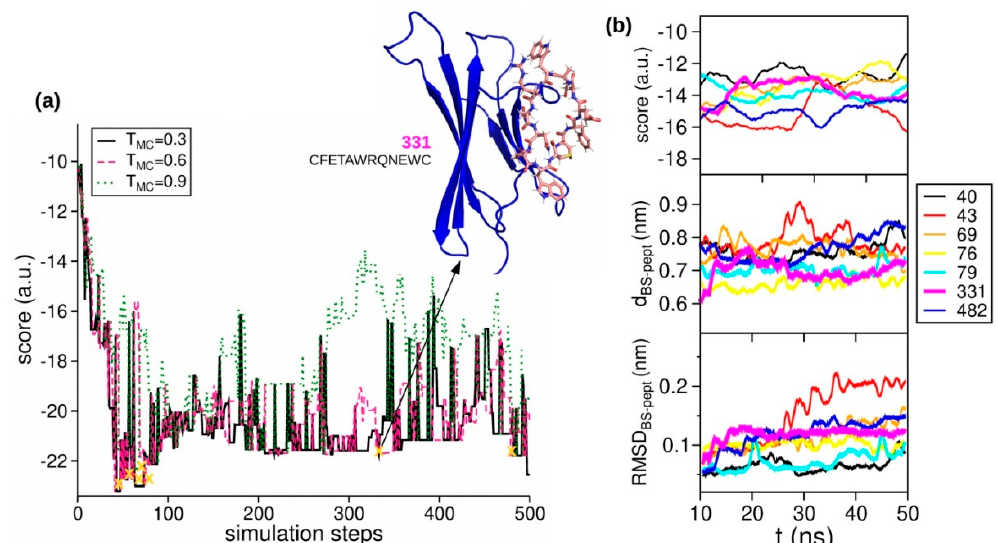
Figure 3. Computational peptide design. ( a ) PARCE optimization path: the optimization was performed by employing three paths with acceptance threshold T MC = 0.3 (black), 0.6 (magenta) 0.9 (green). Peptide mutants that underwent an in silico screening phase are indicated (yellow crosses). In the inset: structure of the peptide pep331, eventually selected for AFM experiments, binding β 2m region B. ( b ) Computational screening of selected peptides by analyzing three descriptors (binding score, distance between peptide and protein binding site, and RMSD) along the MD trajectories of peptide/target complexes.